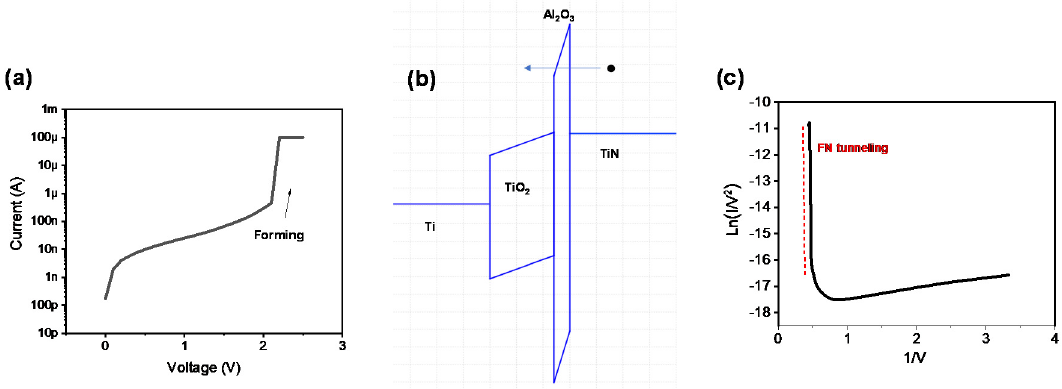
Figure 2. ( a ) Forming I-V characteristics, ( b ) Fowler-Nordheim (FN) tunneling illustration in energy band structure, ( c ) Ln(I/V 2 ) versus 1/V.